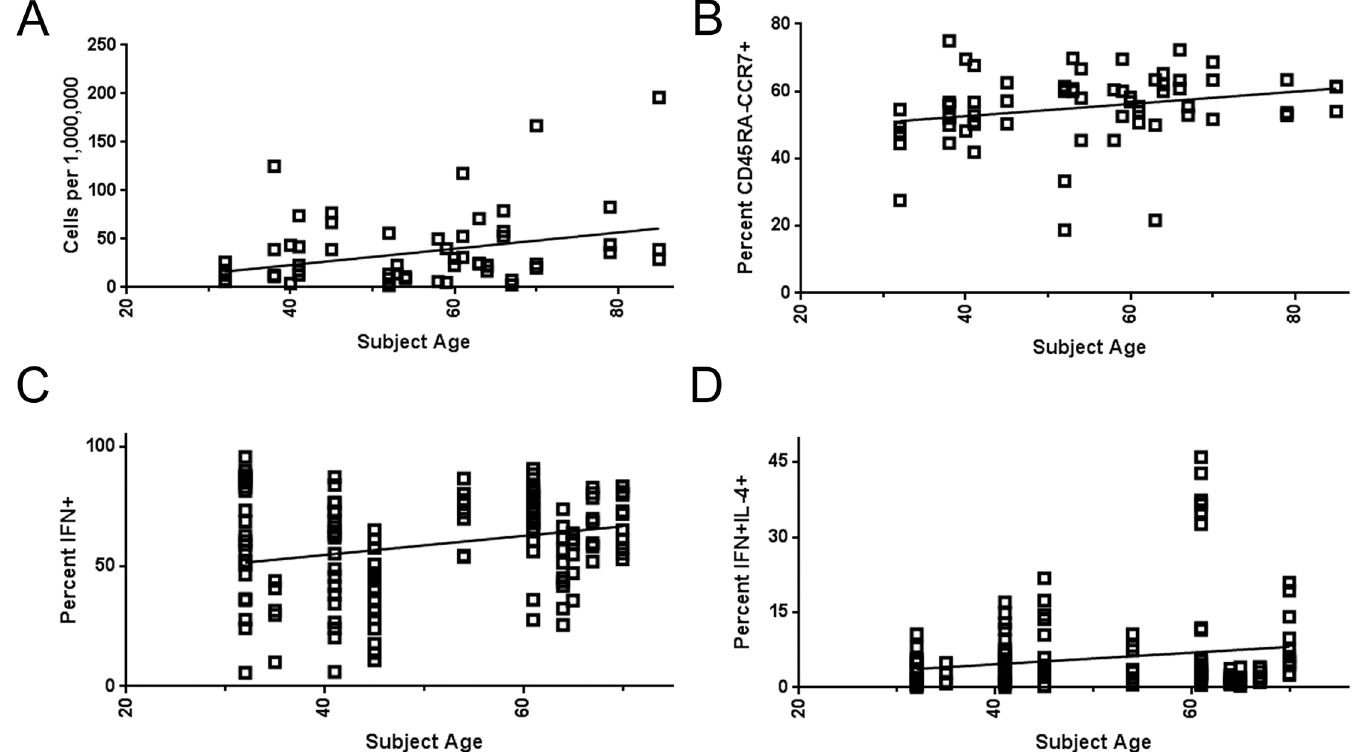
Fig 3. Age related variation in WNV-specific T cell number and function A) Linear regression analysis of WNV-specific T cell number (enumerated by ex vivo tetramer staining for 22 different subjects) versus subject age yielded a positive slope that was significantly non-zero (p = 0.0086) indicating that older subjects tended to have more WNV-specific T cells. B) Linear regression analysis of the percentage of WNV-specific T cells that were CD45RA-CCR7+ versus subject age yielded a positive slope that was significantly non-zero (p = 0.049) indicating that older subjects tended to have a higher proportion of WNV-specific T cells that were TCM. C) Linear regression analysis of IFN- γ production by WNV-specific T cell lines (isolated from 16 different subjects) versus subject age yielded a positive slope that was significantly non-zero (p = 0.0021) indicating that older subjects had a higher proportion of WNV-specific T cells that were IFN- γ positive. D) Linear regression analysis of IFN- γ and IL-4 co-production by WNV-specific T cell lines versus subject age yielded a positive slope that was significantly non-zero (p = 0.031) indicating that older subjects tended to have a higher proportion of WNV- specific T cells that were IFN- γ and IL-4 double